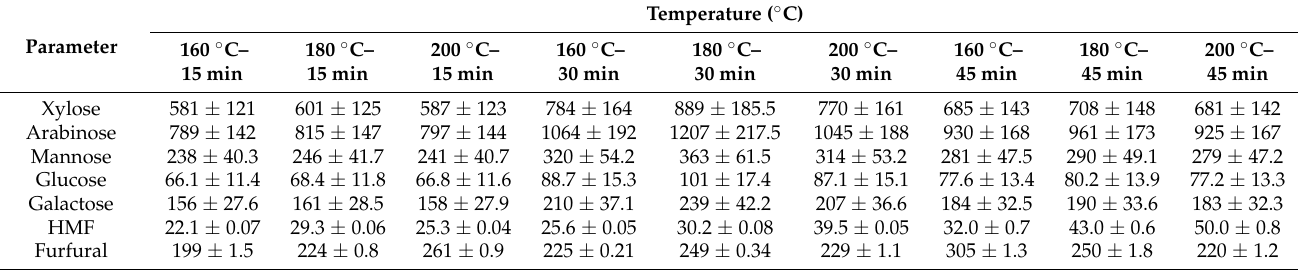
Table 12. The sugar ( µ g mL − 1 ), furfural ( µ g mL − 1 ), and HMF content ( µ g mL − 1 ) in real samples (mean ± U ( k = 2), n = 5 parallel